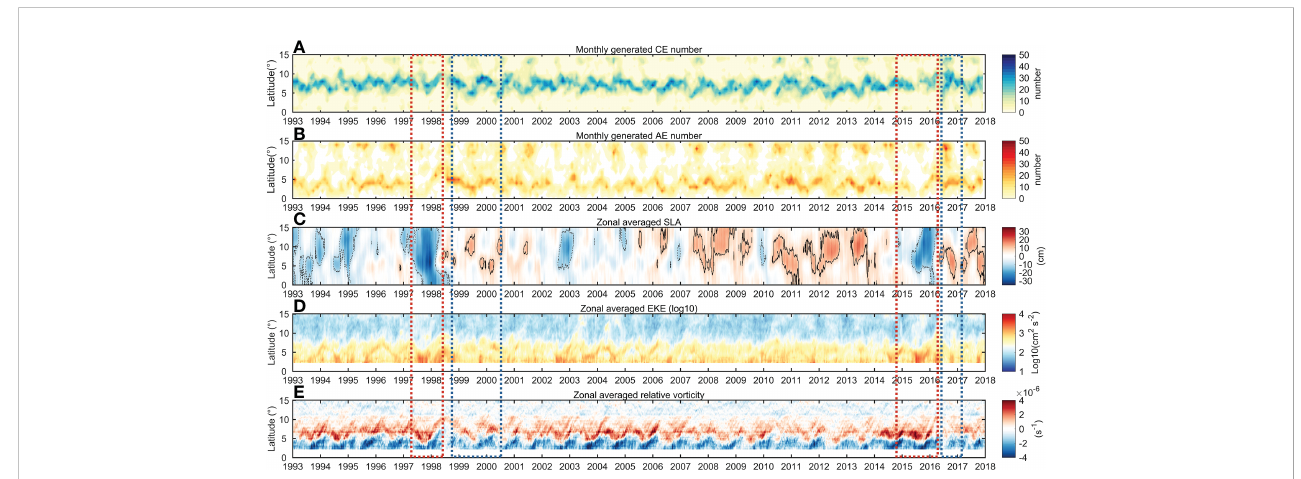
FIGURE 3 Time series of (A, B) the monthly generated ME number at different latitudes, and (C) zonal-averaged SLA, (D) EKE (log10), and (E) relative vorticity from 1993 – 2017. The black dotted (solid) line in c represents the SLA contour line of – 10 cm (10 cm). The calculation is zonal-averaged from 125° – 180°E. The red and blue frames indicate two strong El Niño (1997 and 2015) and La Niña phases (1999 and 2016),